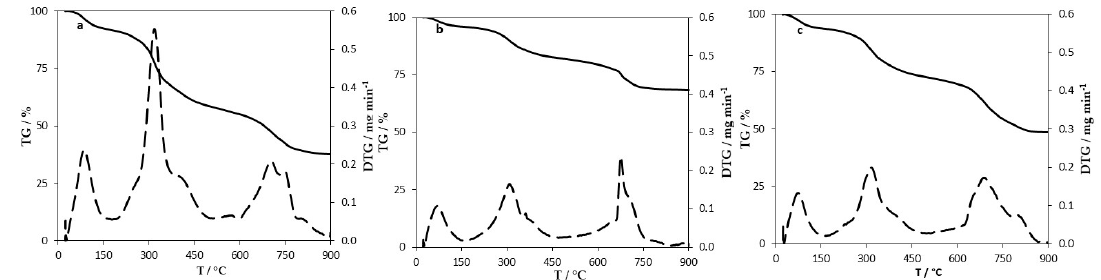
Figure 4. TG (full line) and DTG (dashed lines) curves of MY ( a ), MY@NIPs ( b ), and MY@MIPs ( c ).